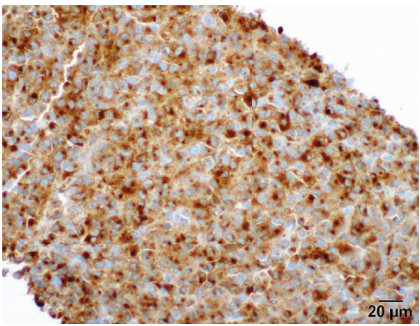
Figure 4: Liver biopsy (MART).